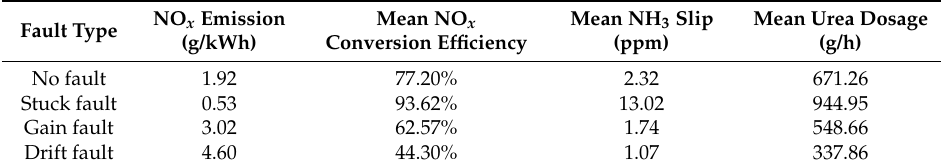
Table 4. Selective catalyst reduction (SCR) performances under different faults.